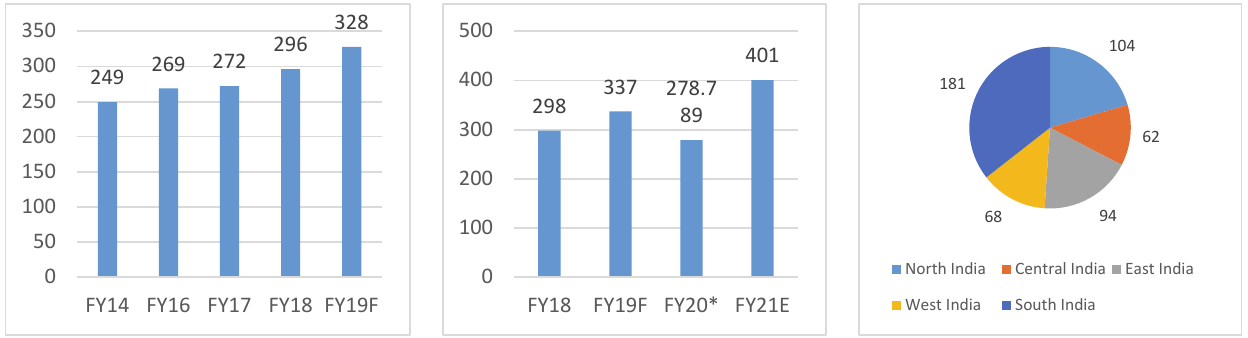
Fig. 1. Cement consumption/ production and region wise cement capacity